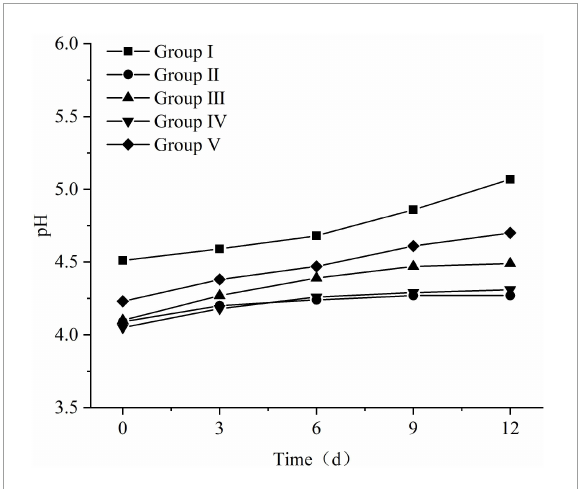
FIGURE6 Changes in pH and microbial of fermented total mixed ration (FTMR) during the aerobic